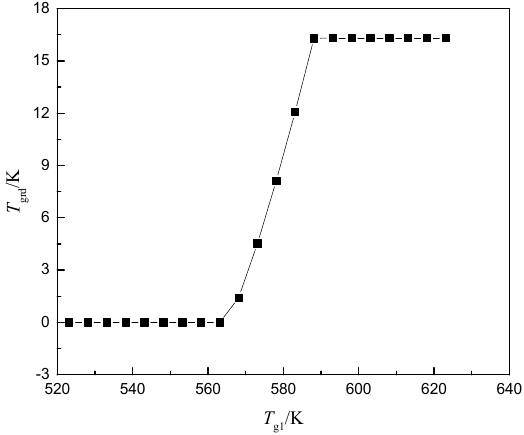
Figure 10. Effects of T g1 on the optimal HTL superheat degree for the cyclopentane system.